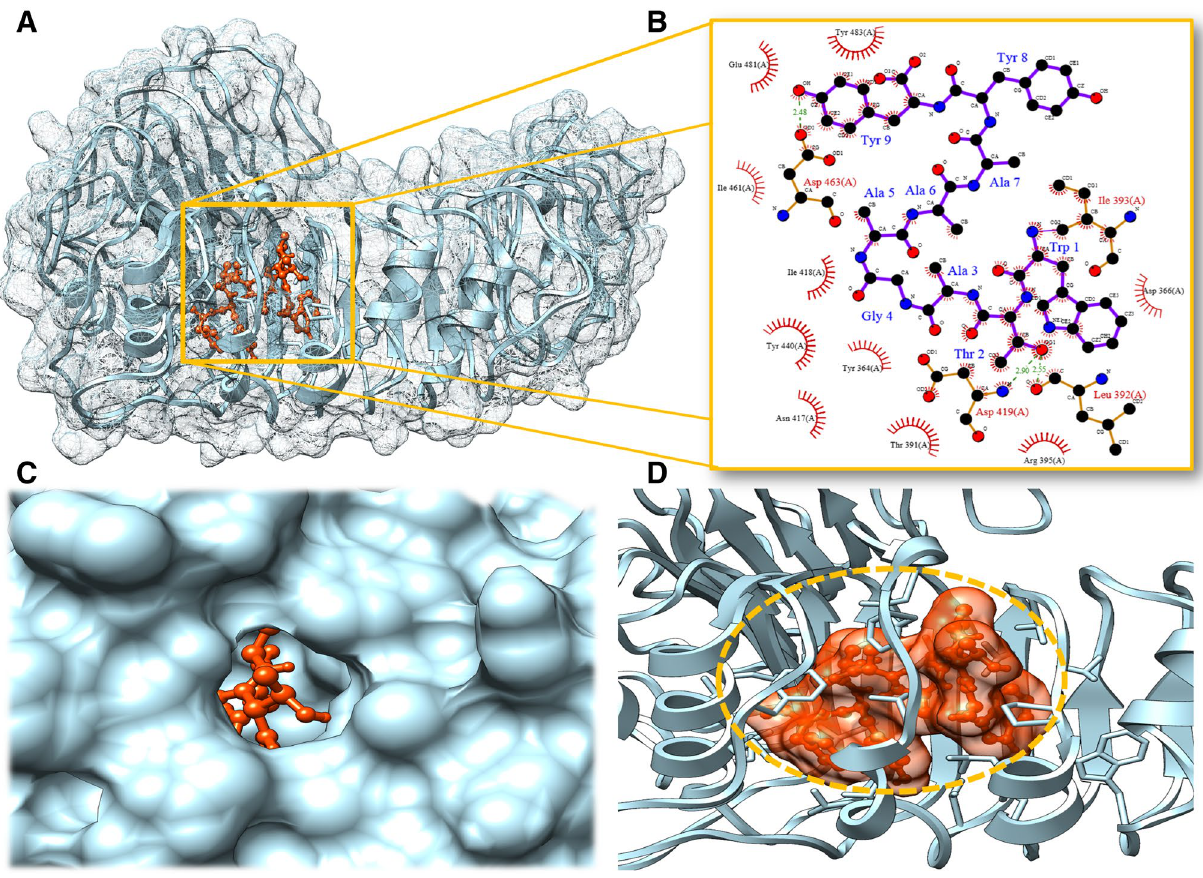
Figure 2. Binding analyses of lead CTL epitope with host membrane specific TLR2 receptor ( A ) Interacting complex of lead CTL epitope with TLR2, mesh network, TLR2 residues shown in sky blue and CTL epitope in orange color. ( B ) Molecular interactions involved in the strong binding of lead CTL epitope to TLR2 receptor. ( C ) Surface view of a binding grove of TLR2 during interaction of CTL epitope. ( D ) CTL epitope binding cavity network responsible strong and stable binding with TLR2.